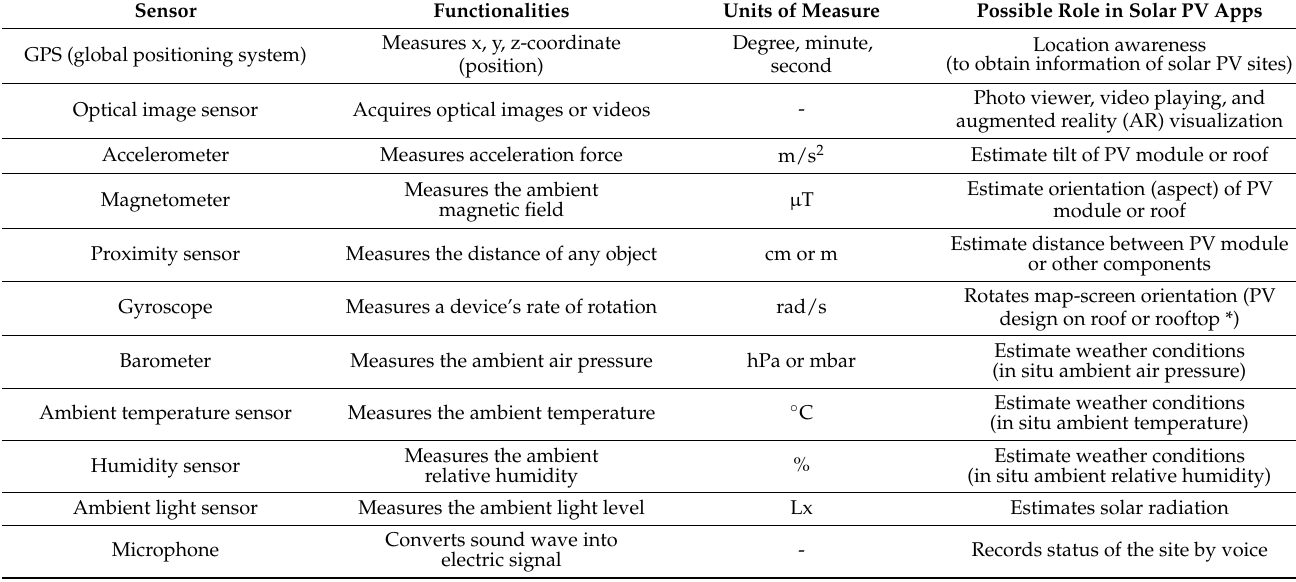
Table 1. Typical sensors embedded in the smartphones and their roles in solar photovoltaic (PV) apps (added from [18]). Sensor Functionalities Units of Measure Possible Role in Solar PV Apps Degree, minute, Measures x, y, z-coordinate Location awareness GPS (global positioning system) (to obtain information of solar PV sites) second (position) Optical image sensor